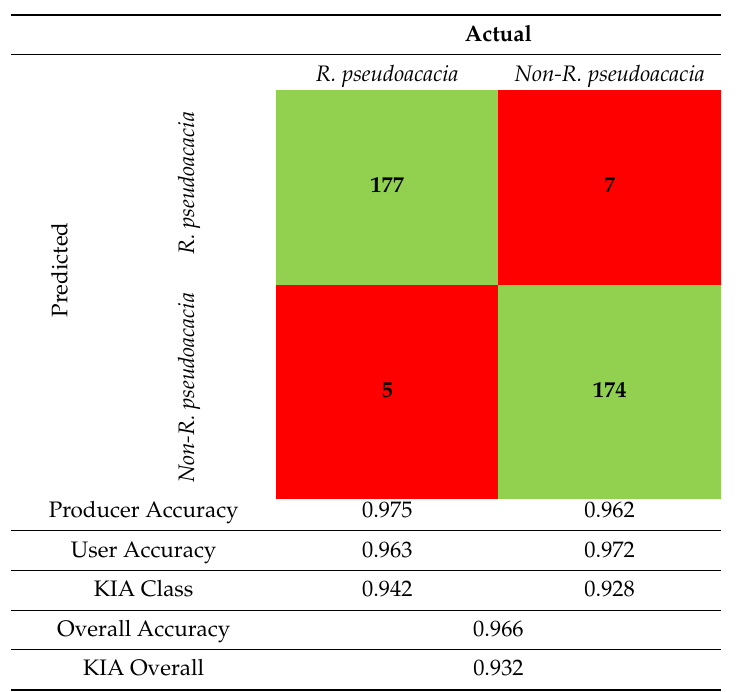
Table 5. Confusion matrix of the classification R. pseudoacacia and non- R. pseudoacacia via object-based image analysis (OBIA). KIA stands for Kappa Index of